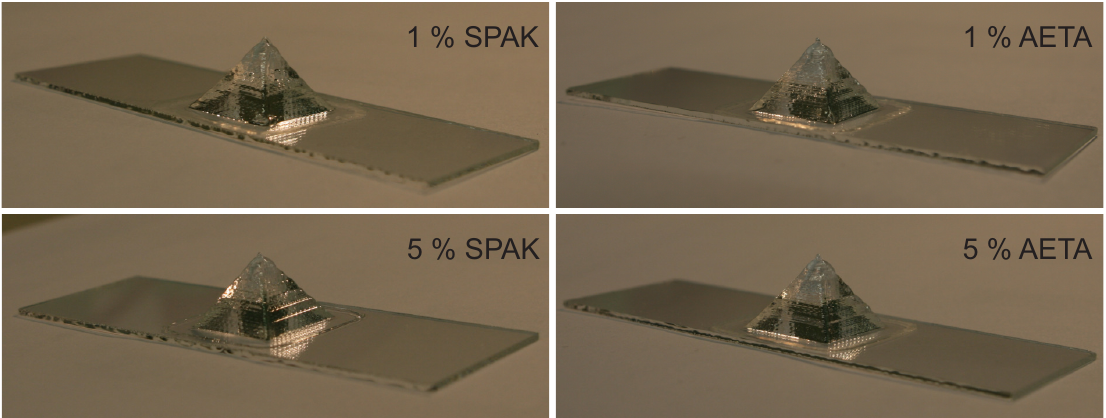
Figure 8. Representative photos of 3D printed hydrogel pyramids of formulations containing 1% and 5% of SPAK and AETA, respectively, as well as 22.5% P407. The objects had an edge length of 20 mm and were printed on glass slides with an area of 26 mm × 76